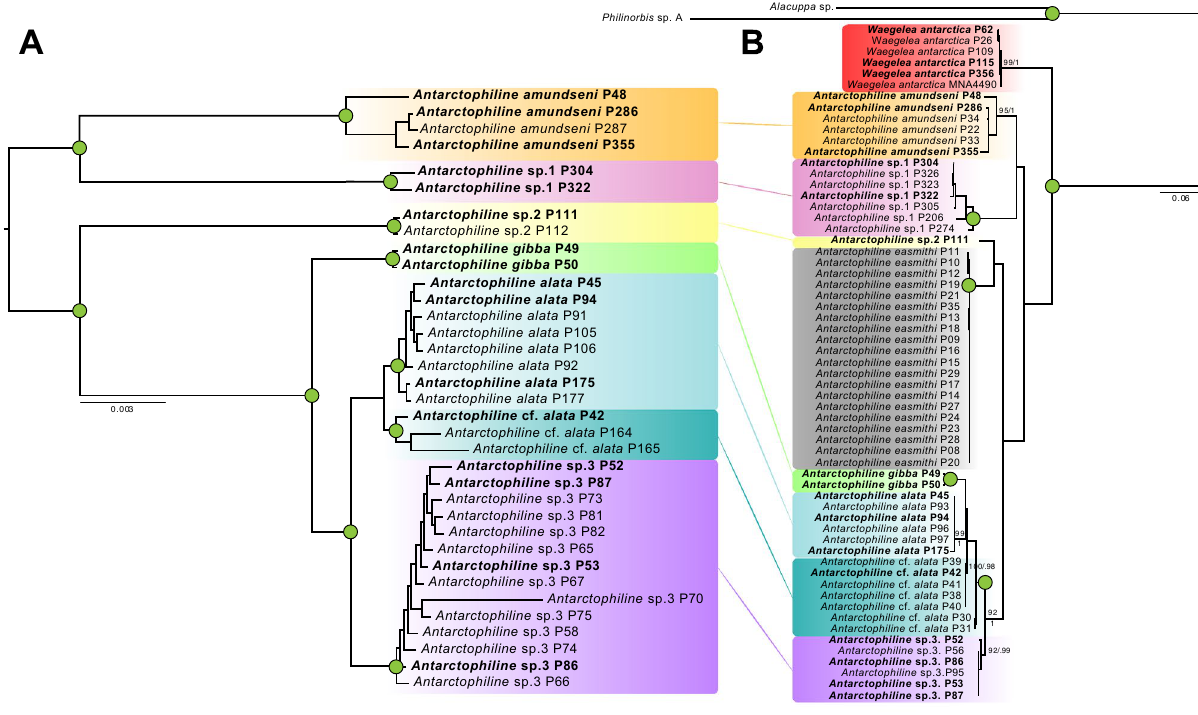
Figure 1. Phylogenetic relationships of antarctophilinids based on maximum likelihood (ML), identical topology was recovered through Bayesian inference (BI), colored boxes illustrating species hypotheses. ( A ) Tree based on ddRADseq data of Matrix 2 (depicted in Figure S1). ( B ) Tree based on COI sequences showing similar clades, but also including the sister group Waegelea antarctica in red and Antarctophiline easmithi in grey. Green dots denote full support for both bootstrap (ML) and posterior probability values (BI). Samples in bold are present in both